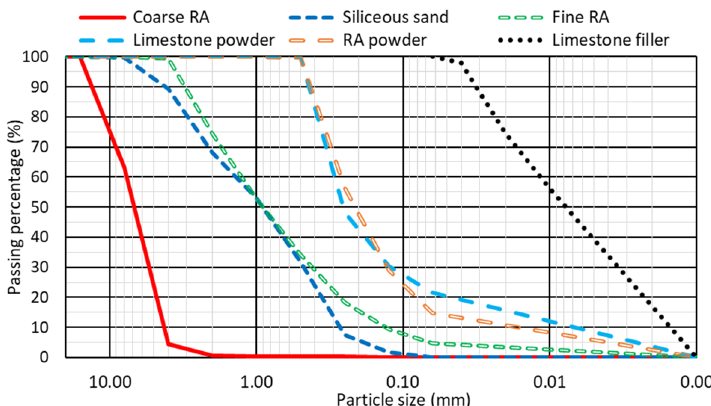
Figure 1. Particle-size distribution of the aggregates.